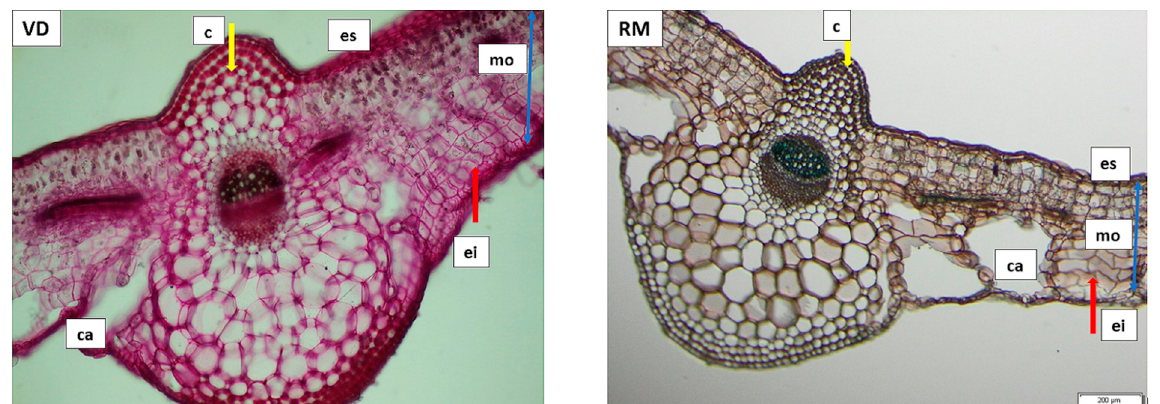
Figure 4. Transversal section of the T. farfara foliar limb through the median vein and mesophyll. Left: Vatra Dornei sample (VD); right: Rar ă u Mountains sample (RM). Legend: es—upper epidermis; ei—lower epidermis; mo—homogenous mesophyll; c—collenchyma; ca—air lacunae.